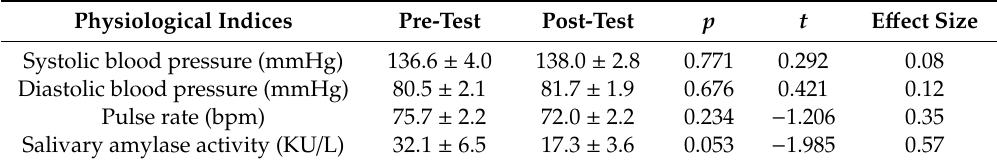
Table 2. E ff ect of Grass Doll on physiological indices.